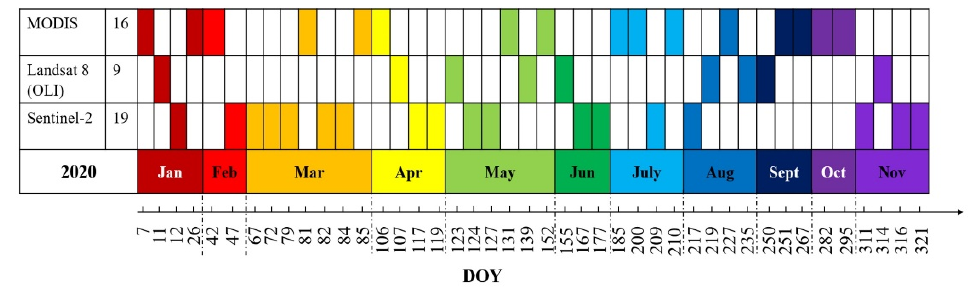
Figure 9. Time distribution of each piece of data in fused time series data.